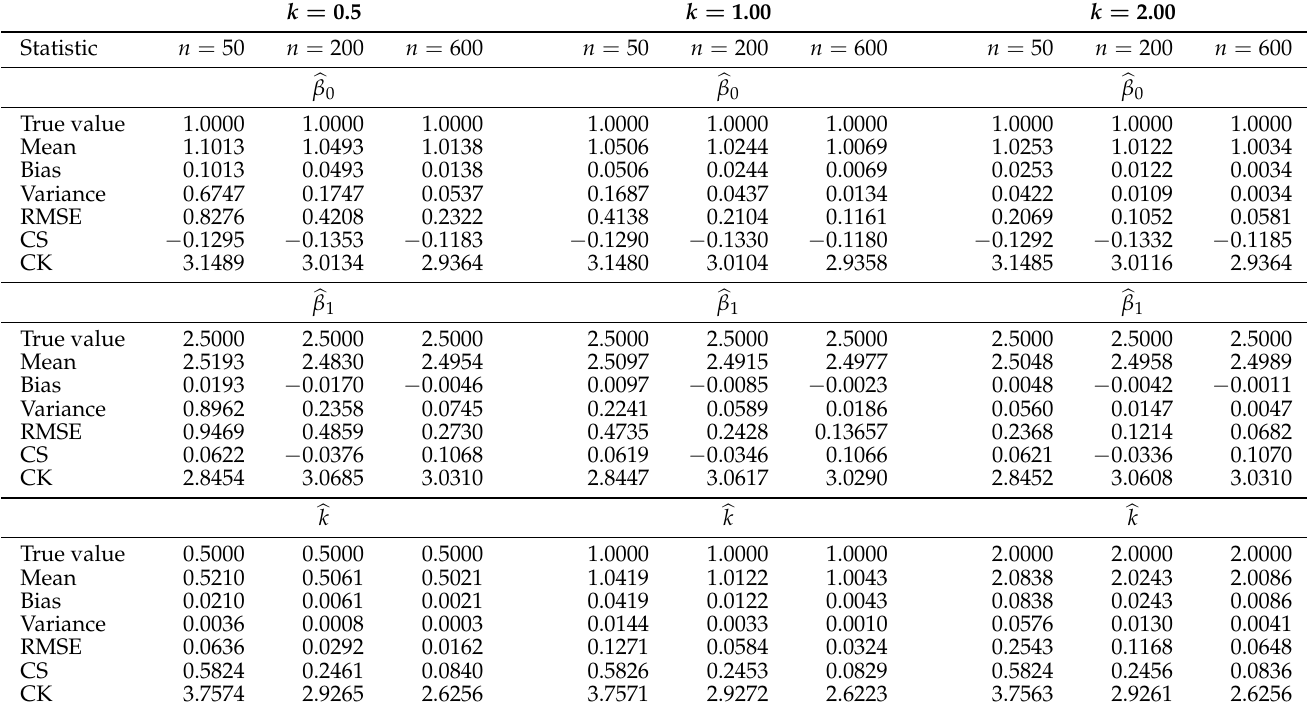
Table 5. Statistics from simulated Weibull regression data ( q = 0.10, β 0 = 1.00, β 1 = 2.50). k = 0.5